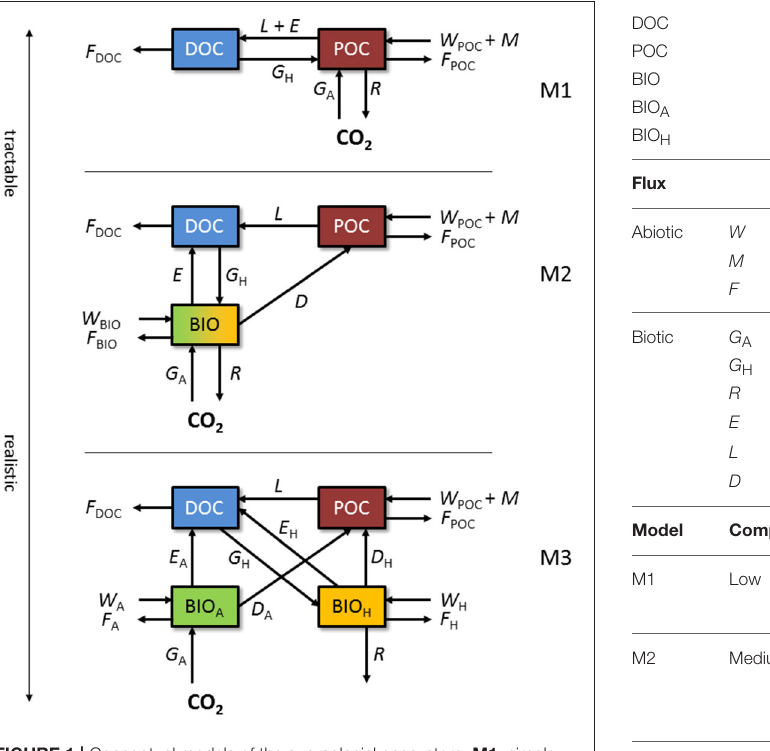
FIGURE 1 | Conceptual models of the supraglacial ecosystem. M1 : simple DOC:POC model in which microbial biomass and processes are included in the POC pool. M2 : model with a separate biomass state variable. M3 : model with biomass divided between autotrophs and heterotrophs. State variables and fluxes are described in Table 1 .